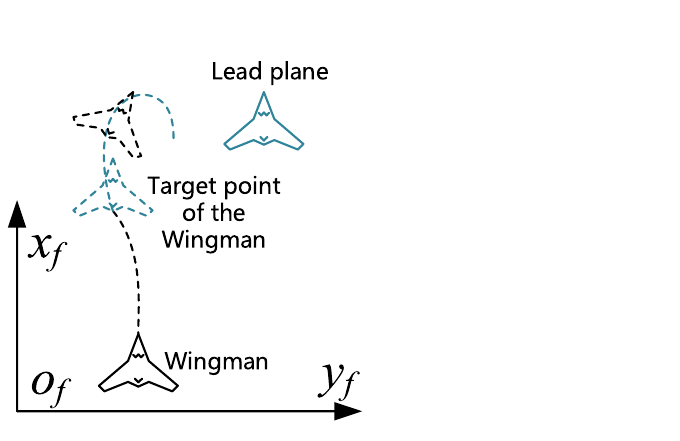
Figure 3. Schematic diagram of UAV, obstacle, and target point collinearity.